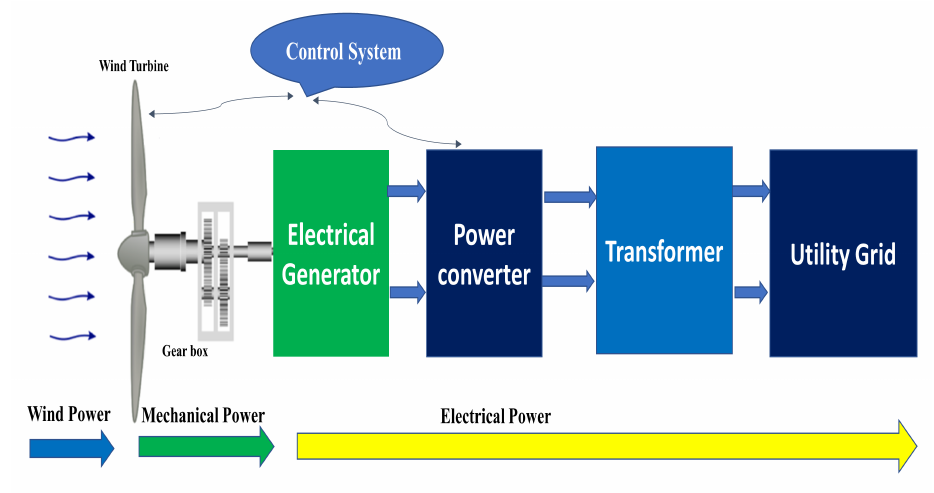
Figure 2. Grid tied WECS general configuration. Reused with permission from ref. [3]. Copyright 2021